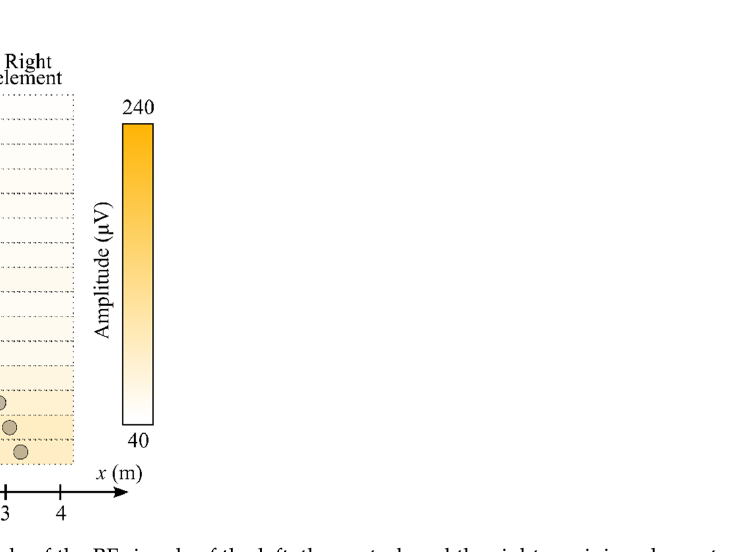
Figure 7. The amplitude of the BF signals of the left, the central, and the right receiving elements (the order is in correspondence to Figure 3) of the array receiver in dependence on different positions of the spherical-cap reflector ( x ). The dark bar is the pole, and the dark circles are the reflector at the different positions. The dotted cells mark space regions of the scene that correspond to fields of view of the receiving elements.